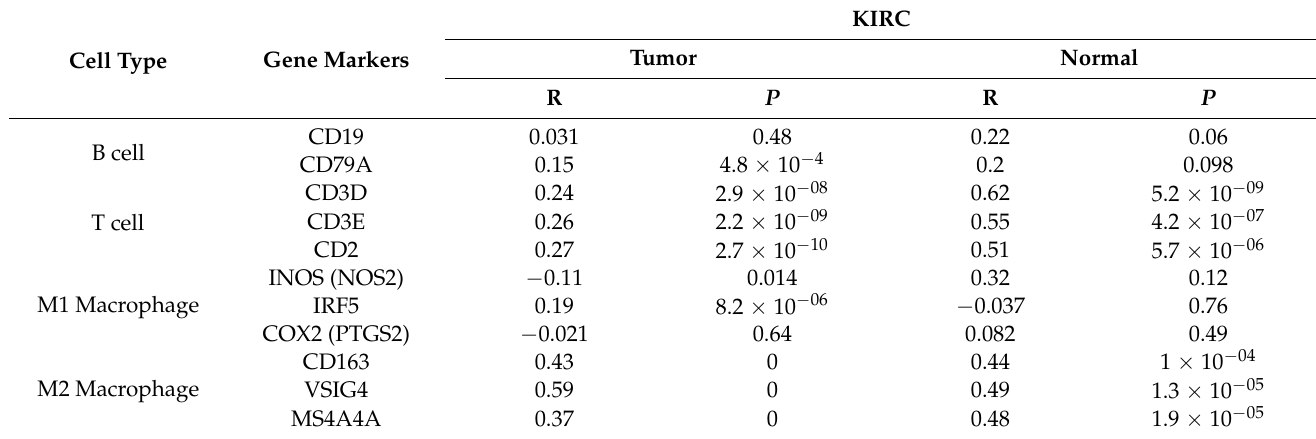
Table 2. Correlation analysis between HAMP and the related marker genes of monocytes and macrophages in